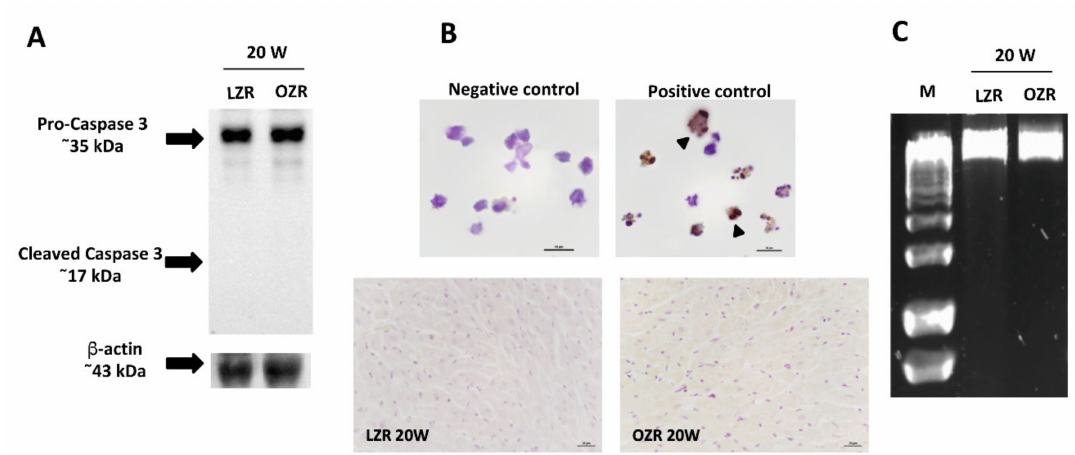
Figure 7. Apoptosis and necrosis. Lysates of the heart, obtained from LZR and OZR, at the age of 20 weeks, were immunoblotted using specific anti-caspase 3 proteases ( A ). β -actin levels were used as the loading control. Blots are representative of three separate experiments. Sections of the heart of 20 weeks old LZR and OZR were processed for the TUNEL. The specificity of the reaction was evaluated by using the negative and positive controls (head of the arrow) provided by kit ( B ). Calibration bar 25 µ m. DNA ladder was absent in the samples of 20 weeks old LZR and OZR ( C